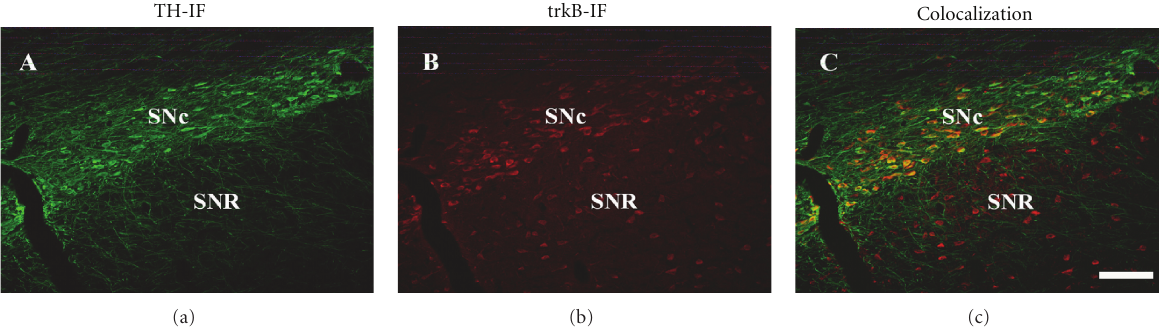
Figure 5: TH and trkB immunoreactivities are highly colocalized in rat SNc. Immunofluorescent detection of TH (a) and trkB (b) in SN in untreated na¨ıve rats. (c) Merge of (a) and (b). (a)–(c) scale bar = 150 μ m. SNc: substantia nigra pars compacta; SNR: substantia nigra pars